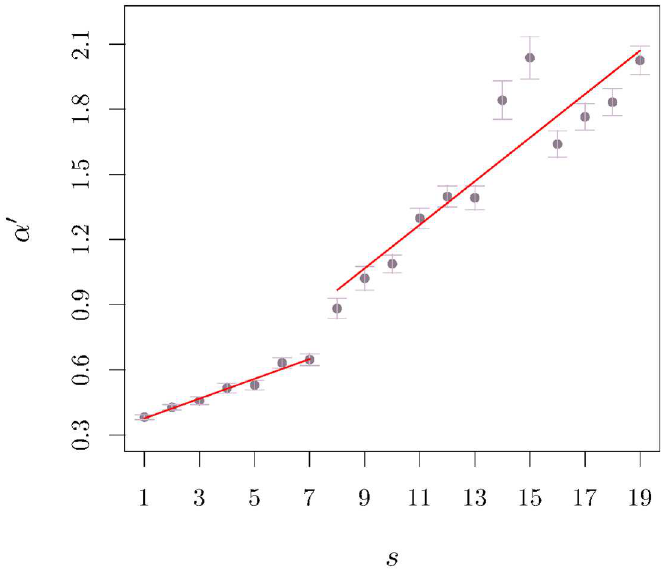
Fig 3. Closing exponent α 0 v semester s . The symbols represent the exponent α 0 in Eq (10) averaged over the companies and the respective deviationbars. The solid lines represent the best fit up to 1S07 with a slope 0.046 ± 0.004 and from that semester we identify a second regime with a slope equal to 0.1 ± 0.01. The correlationcoefficient for each of these numerical adjustments is R = 0.97 and R = 0.836,